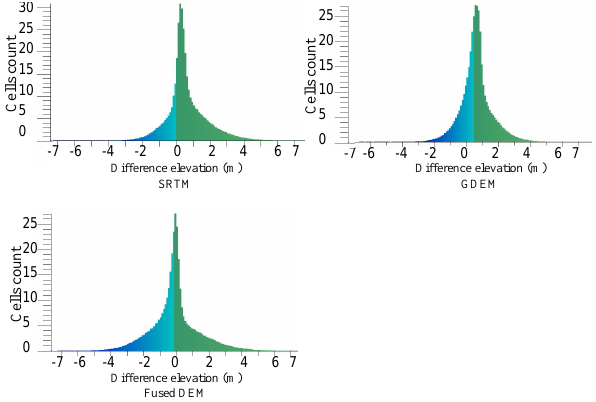
Figure 15. Histogram from the difference elevation maps of SRTM, GDEM and the fused DEM ( x axis: cell values in tens; y axis: num- ber of cells in thousands).